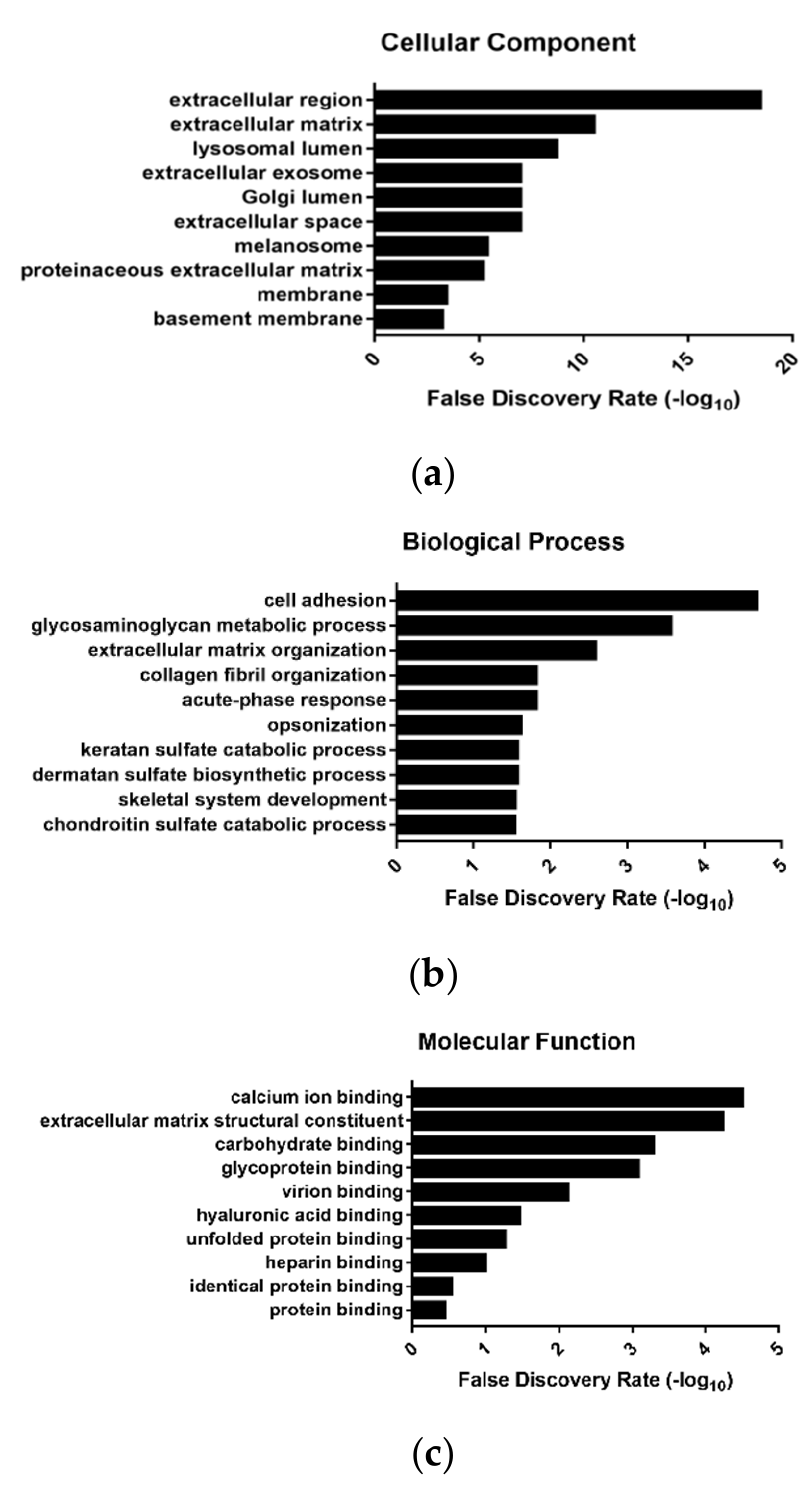
Figure 3. Gene Ontology (GO) distribution of proteins more abundant in ALCL samples. The top 10 significantly enriched GO terms in ALCL S-EVs: cellular component ( a ), biological process ( b ) and molecular function ( c ). Only GO terms represented by ≥ 3 genes were considered and ranked according to decreasing − log 10 of false discovery rate (FDR).